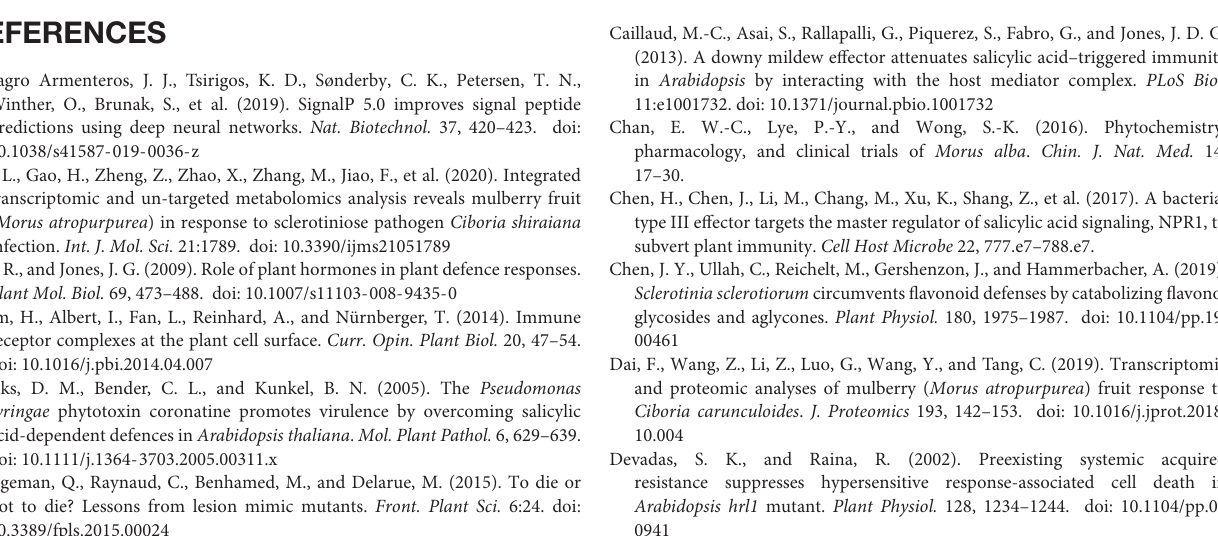
Supplementary Figure 1 | Mulberry fruits for RNA-seq uninfected and infected with Ciboria carunculoides . Supplementary Figure 2 | Statistics analysis of the number of genes obtained by RNA seq. (A) The numbers of genes belonging to plants and fungi were identified in all samples. (B) Differentially expressed genes (DEGs) in mulberries infected with Ciboria carunculoides at three different stages. Supplementary Figure 3 | Kyoto Encyclopedia of Genes and Genomes (KEGG) pathway enrichment analyses of DEGs in stage 2 and stage 3. (A) Top 20 pathways of KEGG enrichment in stage 2. (B) Top 20 pathways of KEGG enrichment in stage 3. Supplementary Figure 4 | Amino acid sequence alignment of CcSSP1 and its homologs in different fungi and oomycetes. Oomycetes are shaded on a gray background. Conserved amino acid residues are shaded on a black background. The eight conserved cysteine residues are individually annotated. Supplementary Figure 5 | Representative pictures of long-fruit mulberry with different disease levels. Supplementary Table 1 | Primers used in this